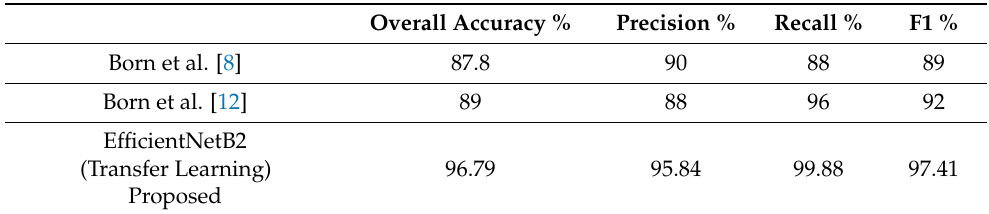
Table 7. Performance of the proposed architecture compared with the accuracies of models proposed by the authors of the